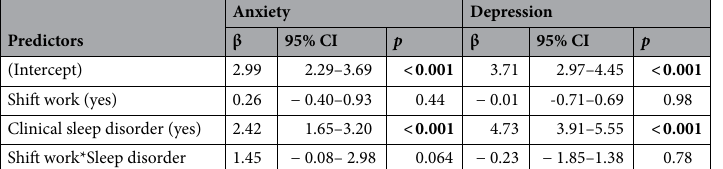
Table 3. Adjusted associations between shift work, sleep disorder status and mental health endpoints. Significant values are in [bold]. Models adjusted for sex, health comorbidities, and typical work hours/week. Anxiety is measured with the GAD-7 (range from 0–21), and depression is measured with the PHQ-9 (range from 0–27).